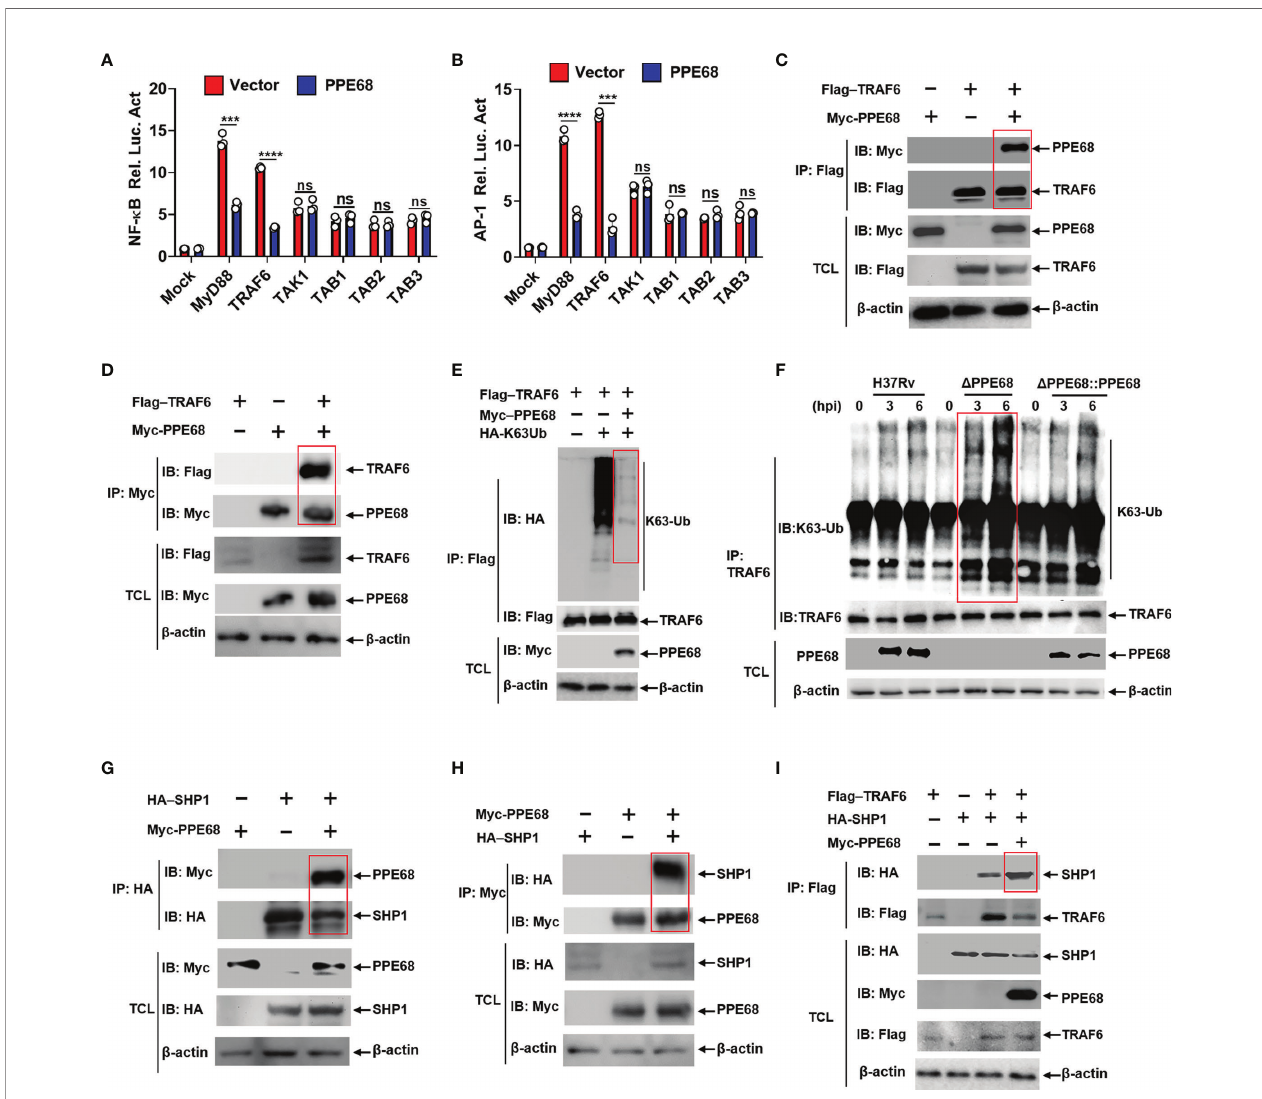
FIGURE 3 | PPE68 interacts with TRAF6 and inhibits TRAF6-NF- k B/AP-1 in fl ammatory signaling by binding SHP1. (A, B) Dual luciferase reporter assay of the effects of PPE68 and various signaling molecules (MyD88, TRAF6. TAK1, and TAB1-3) on the NF- k B (A) or AP-1 (B) activation in HEK293T cells. (C-E, G-I) HEK293T cells were transfected with the indicated plasmids for 24 h, and then cell lysates were analyzed by Co-IP and Western blot. Co-IP and Western blot (C) and reversible Co-IP and Western blot (D) showed the interaction between PPE68 and TRAF6 (C, D) . PPE68 overexpression suppresses TRAF6 K63 ubiquitination (E) . Co-IP and Western blot (G) and reversible Co-IP-WB (H) showed the interaction between SHP1 and PPE68 (G, H) . PPE68 promotes the interaction between TRAF6 and SHP1 (I) . (F) H37Rv or Rv D PPE68::PPE68, but not Rv D PPE68, suppresses TRAF6 K63 ubiquitination. BMDMs were infected with H37Rv, Rv D PPE68 or Rv D PPE68::PPE68 (MOI = 10) for the indicated time; cell lysates were immune-precipitated with an anti-TRAF6 antibody and then analyzed by Western blot with an anti-K63-Ub antibody. TCL, total cell lysates. Data are expressed as the mean ± SD of three independent experiments for A and B, and two tailed unpaired t test was used to calculate statistical signi fi cance. p > 0.05, not signi fi cant (ns); *** p < 0.005; **** p <